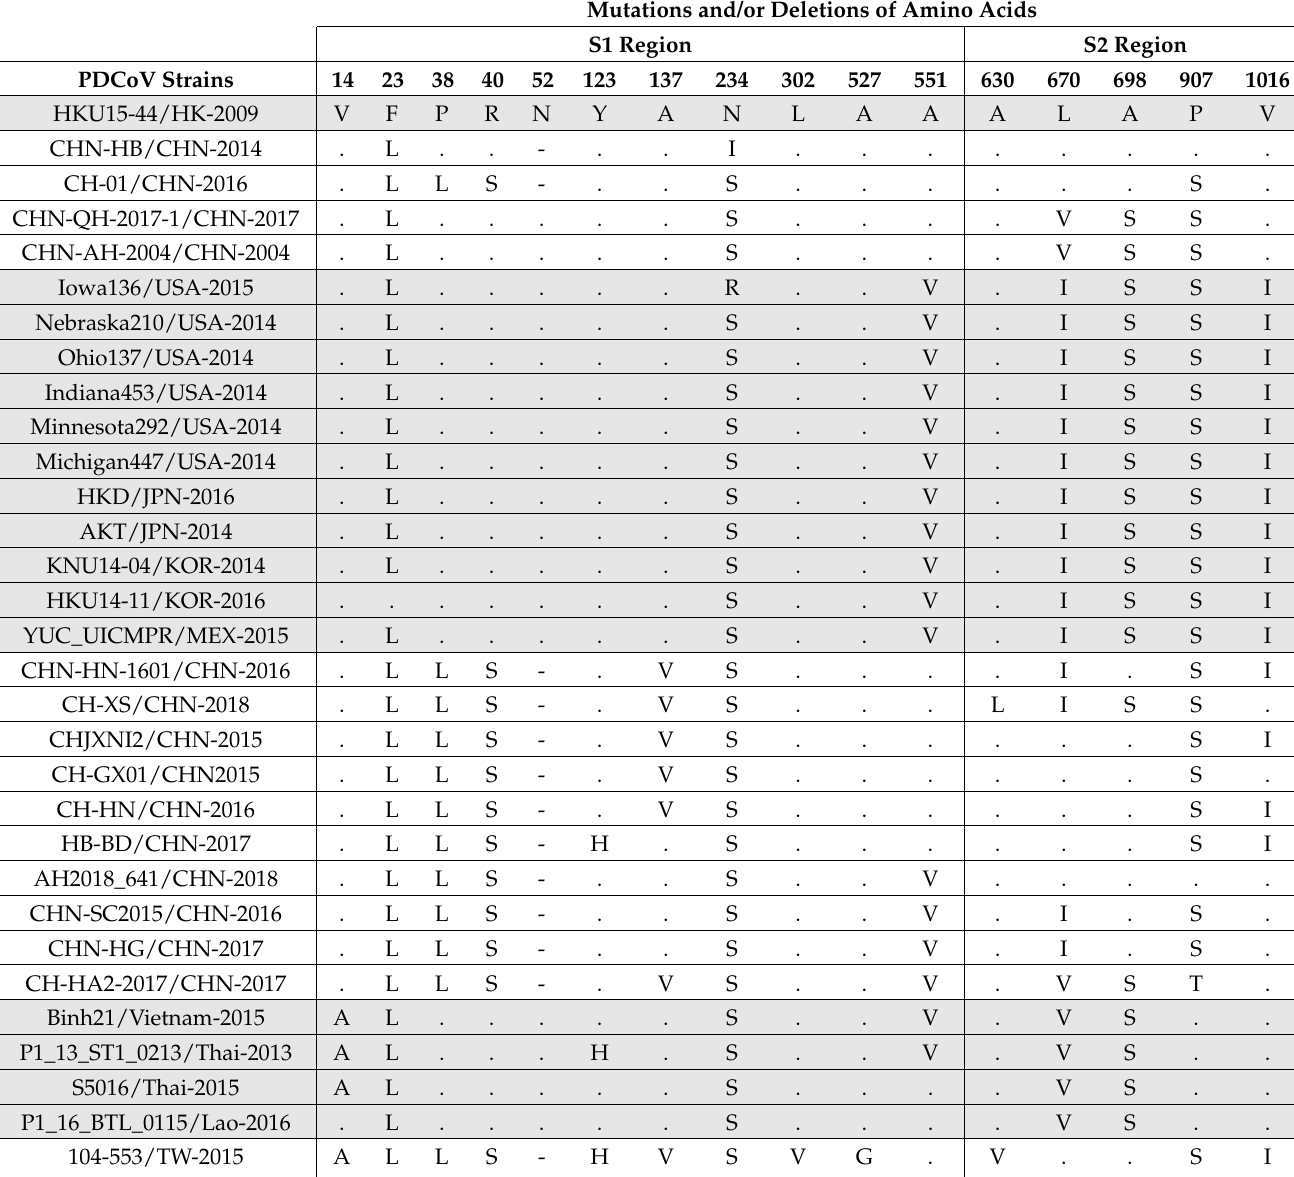
Table 2. Comparison of amino acid mutations of the S protein among the Taiwan 104-553 strain and historical reference strains from each genogroup. PDCoV strains represented the G-I (HKU15-44/HK-2009), undetermined strain (CHN- HB/CHN-2014 strain to CHN-AH-2004/CHN-2004 strain), G-II-a (Iowa136/USA-2015 strain to YUC_UICMPR/MEX- 2015 strain), G-II-b (CHN-HN-1601/CHN-2016 strain to CH-HA2-2017/CHN-2017), and G-II-c (Binh21/Vietnam-2015 to P1_16_BTL_0115/Lao-2016) genogroups, respectively. Dots indicate the analogous amino acids. Dashes denote deletions. Mutations and/or Deletions of Amino